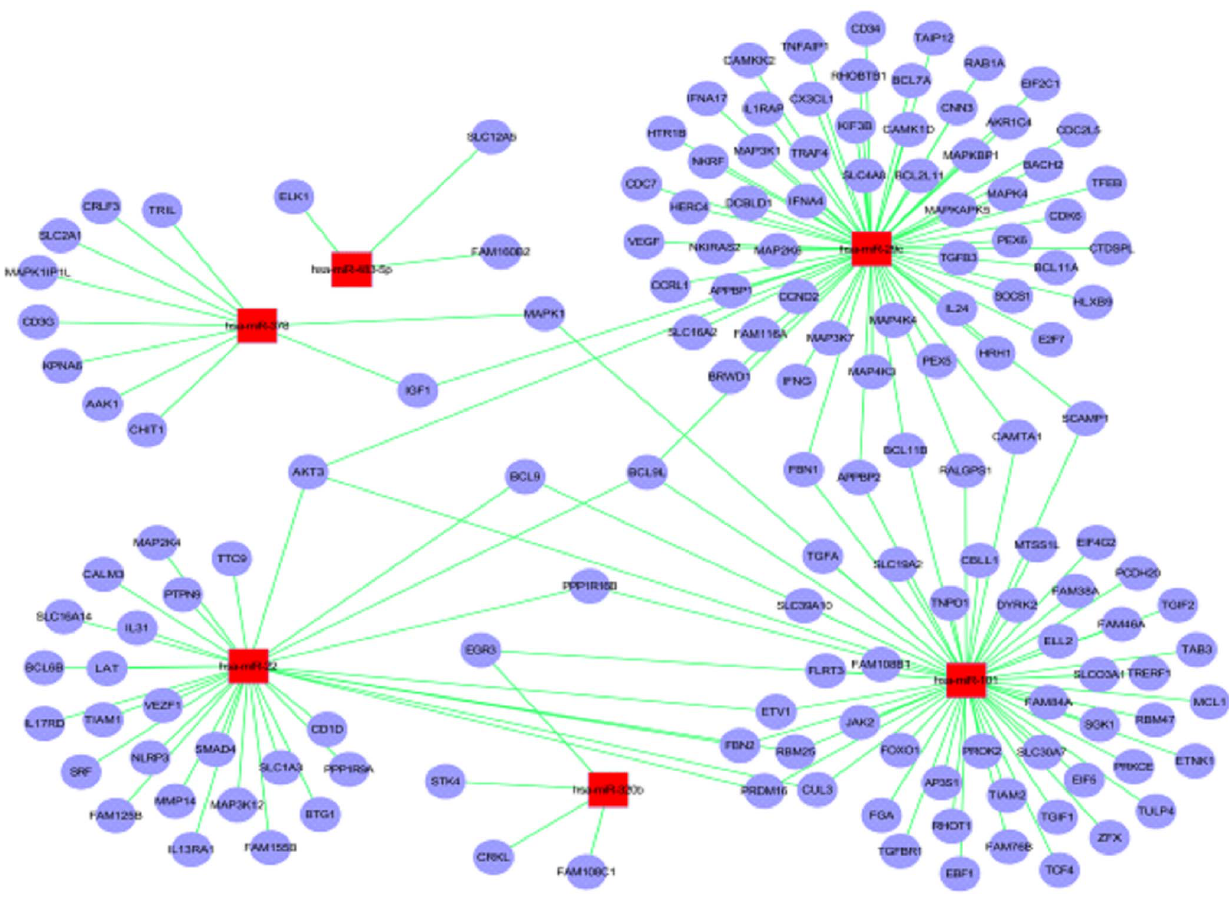
Figure 4. The miRNA-gene-network for the association between miRNAs and genes related to pulmonary TB. The miRNA-gene- network was constructed using the gene expression data and the predicted interactions in the TargetScan miRNA database. Circles represent genes and squares represent miRNAs; their relationship is represented by one edge. The center of the network represents the degree.